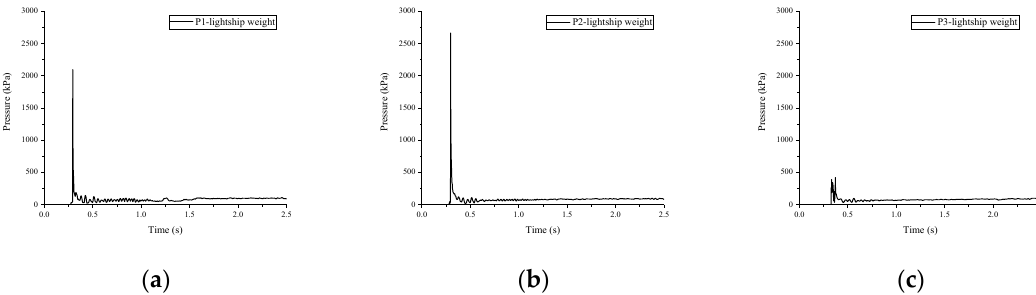
Figure 16. Slamming force of the parallel middle body at each loading condition: ( a ) Lightship weight; ( b ) half load; ( c ) full load.